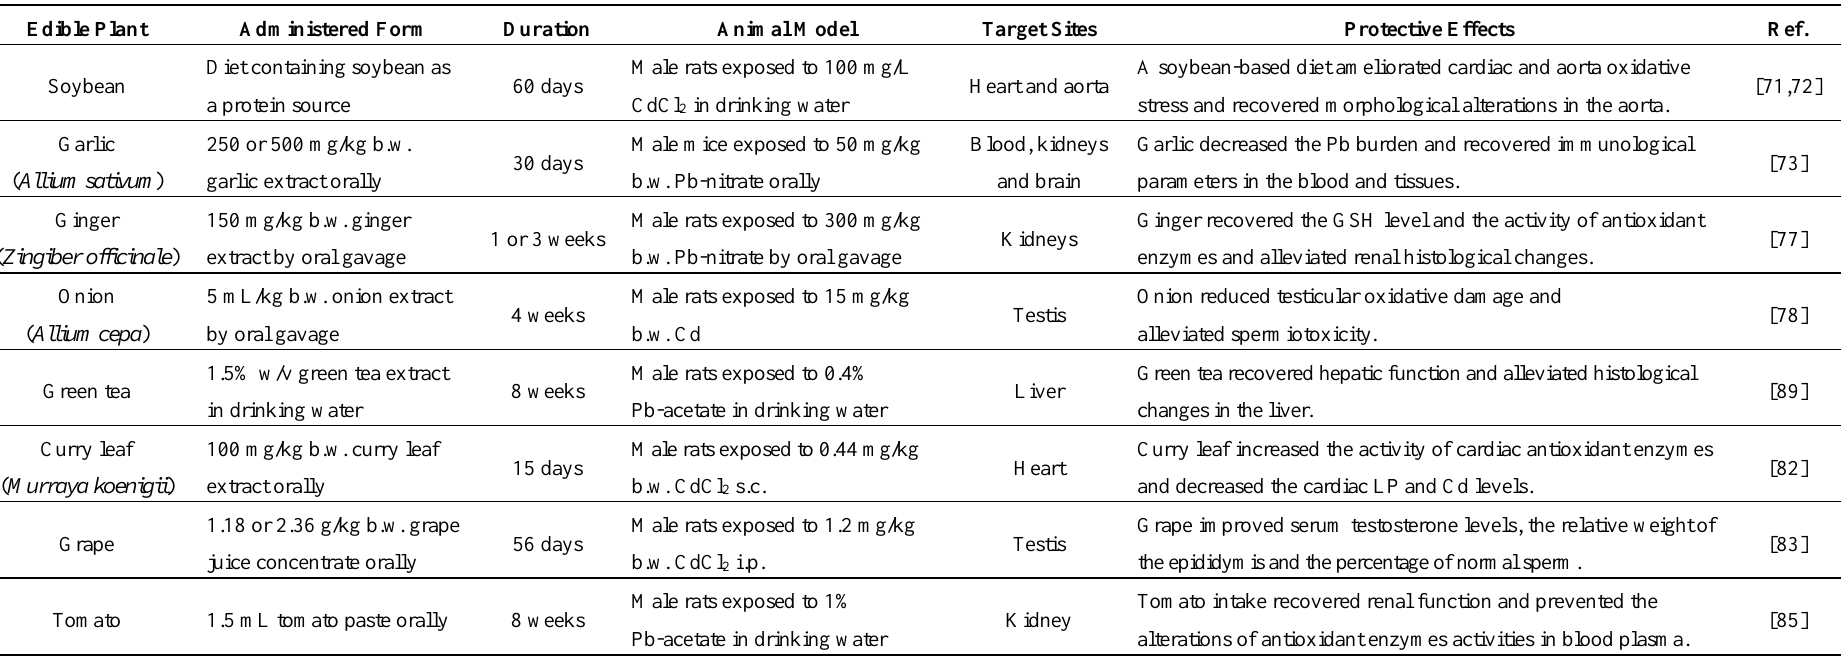
Table 2. Selected studies on the protective effects of edible plants against Cd and Pb